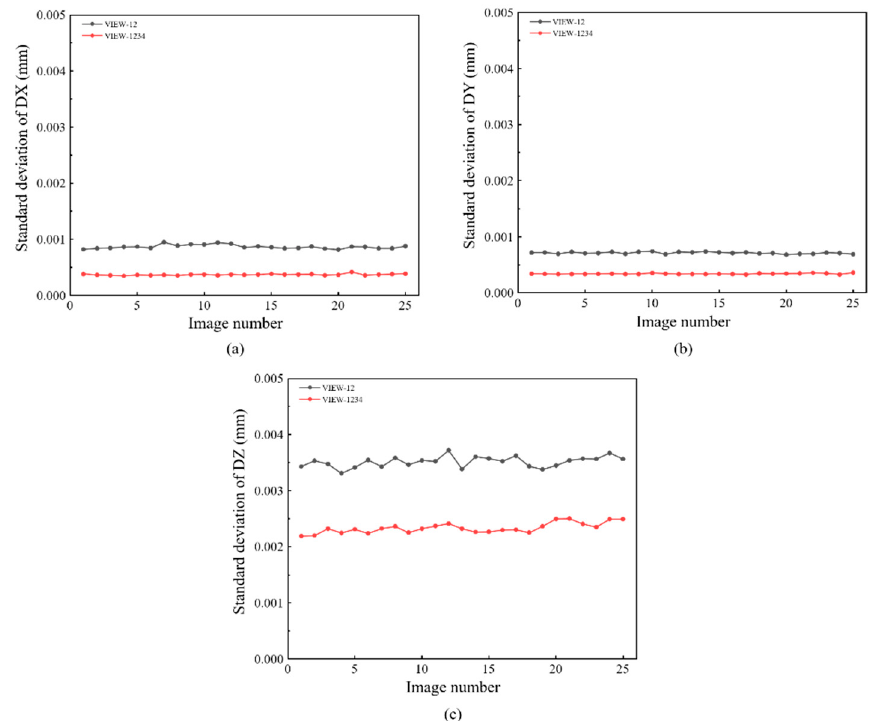
Figure 10. Comparisons of displacement standard deviation in static experiment between case VIEW-12 (results obtained from camera1 and camera2) and case VIEW-1234 (results obtained from four cameras): ( a ) DX; ( b ) DY; ( c ) DZ.